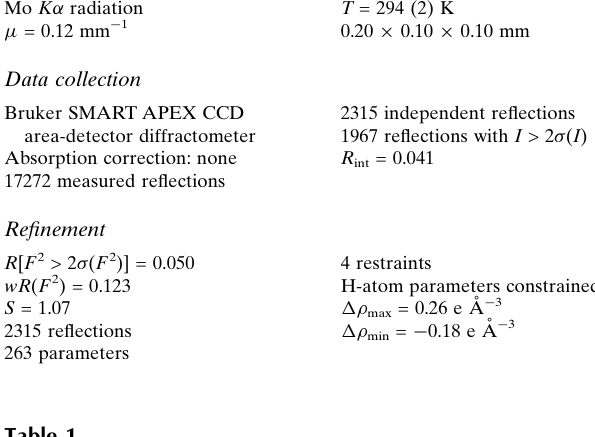
Hydrogen-bond geometry (A˚ , (cid:1)